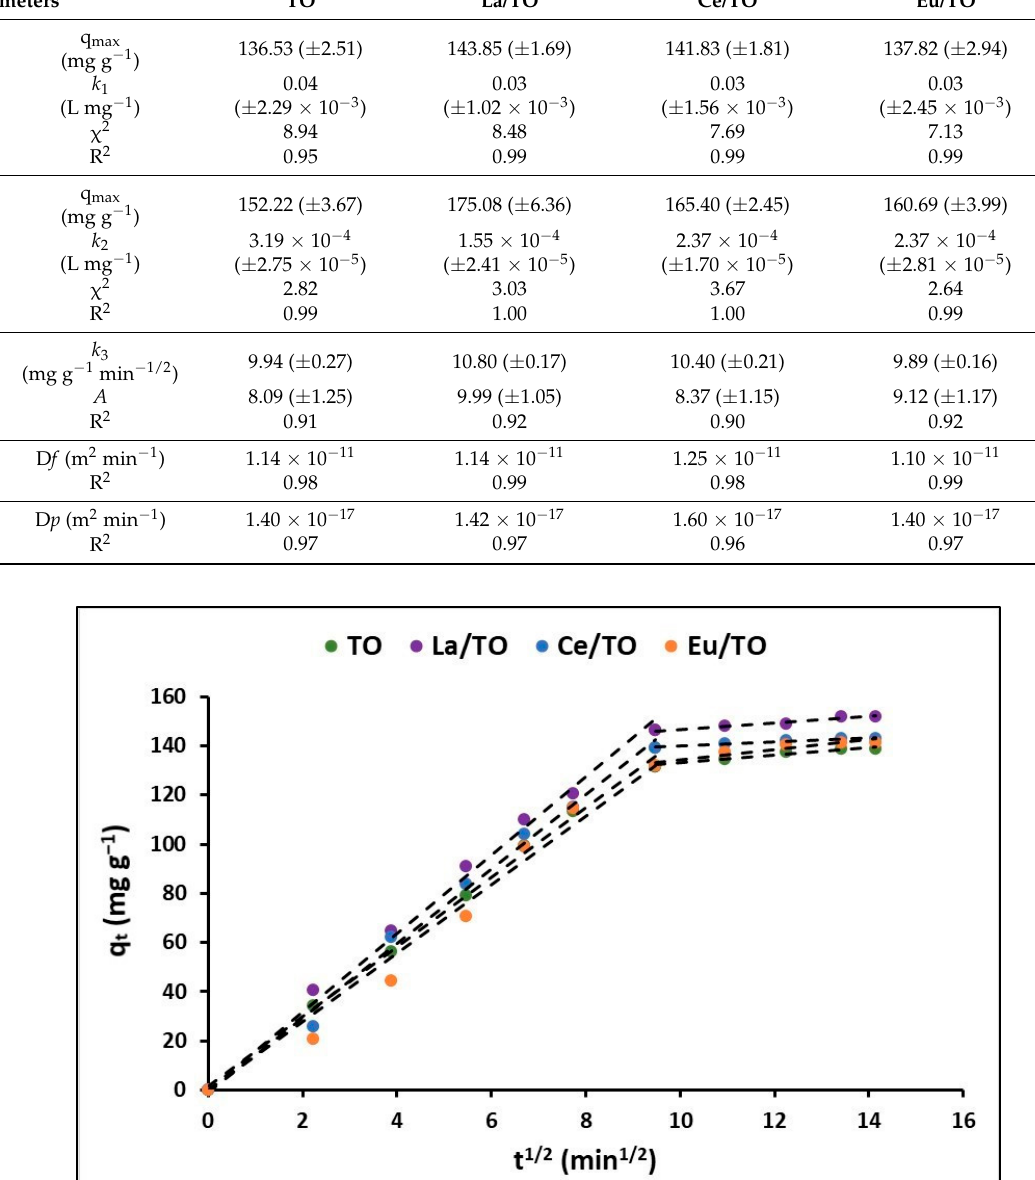
Table 4. Kinetic parameters for cyanide sorption on nanoparticles. Kinetic Parameters TO La/TO Ce/TO Eu/TO